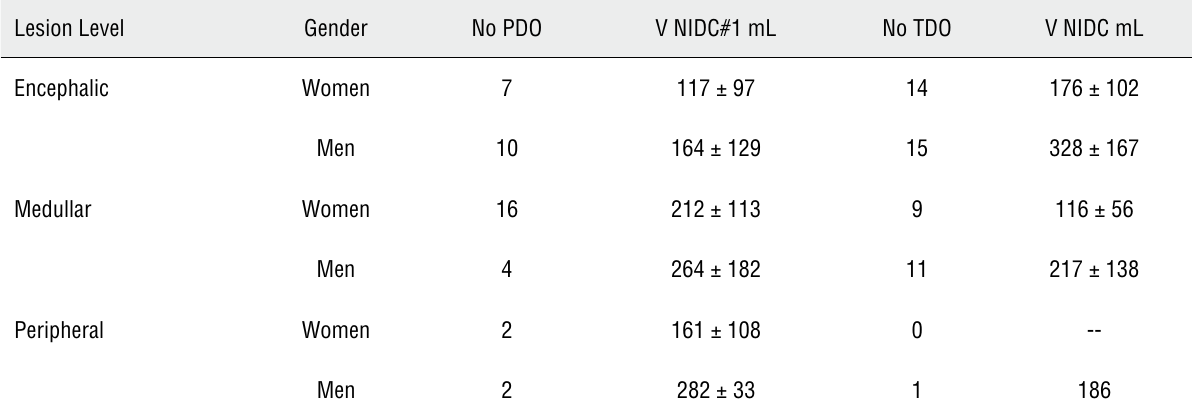
Table 2 - volume at the first non-inhibited detrusor contraction (NIDC#1) for patients with neurological detrusor overactivity (NDO) vs. level of neurological lesion (PDO: phasic detrusor overactivity, TDO: terminal detrusor overactivity). Lesion